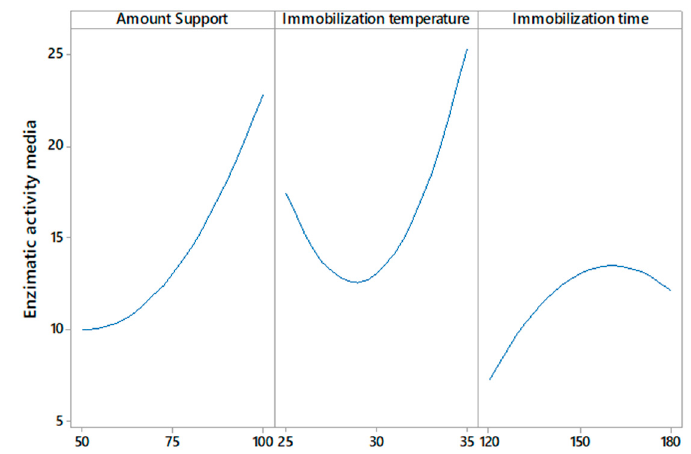
Figure 3. Effect of amount support, immobilization temperature, and immobilization time on enzy- matic